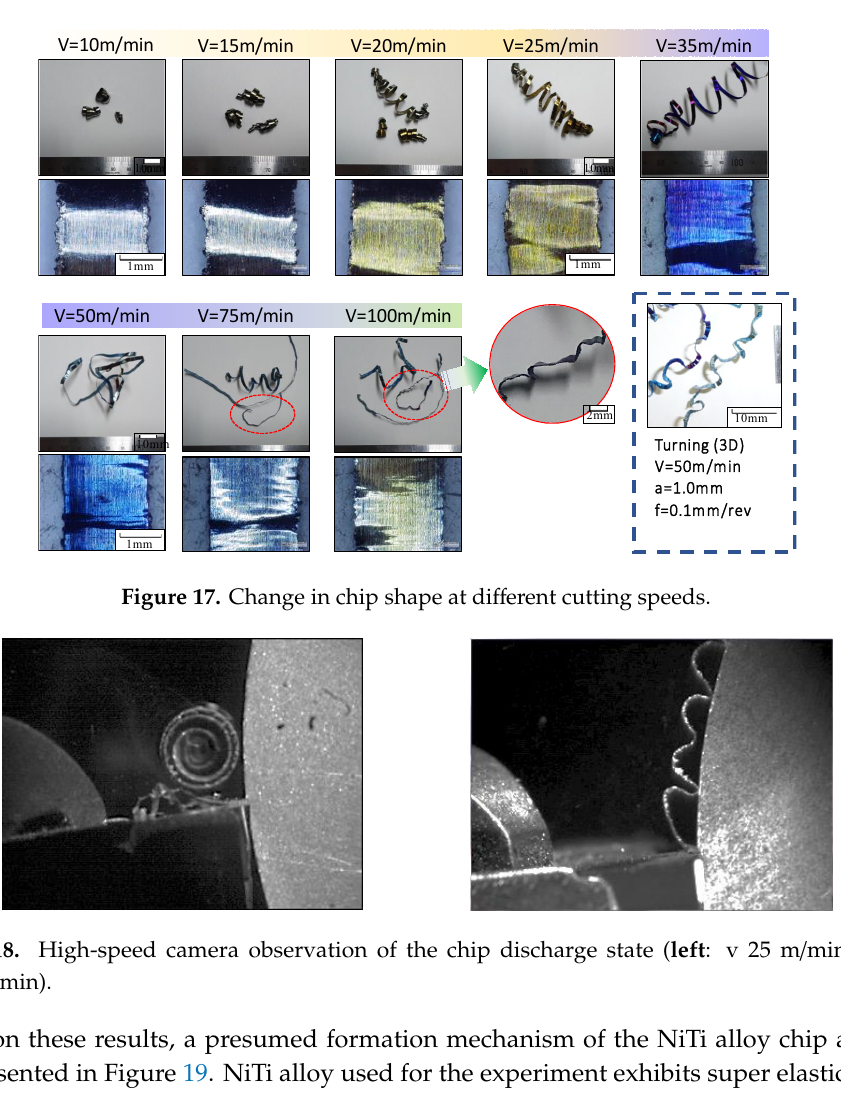
Figure 16. Results of XPS analysis of the chips.